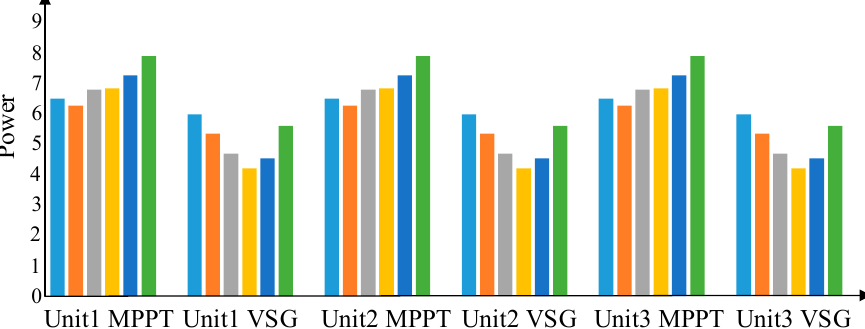
Figure 14. Upward reserve allocated for SGs with RG under MPPT or VSG mode.